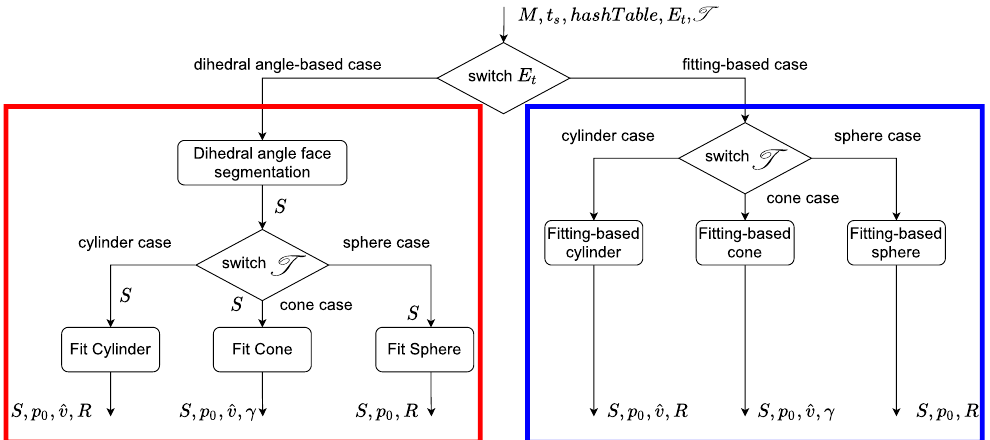
Figure 2. Fitting process. Left (red) block: segmentation/fitting decoupled. Real-time identification of g () . Right (blue) block: codependent segmentation and